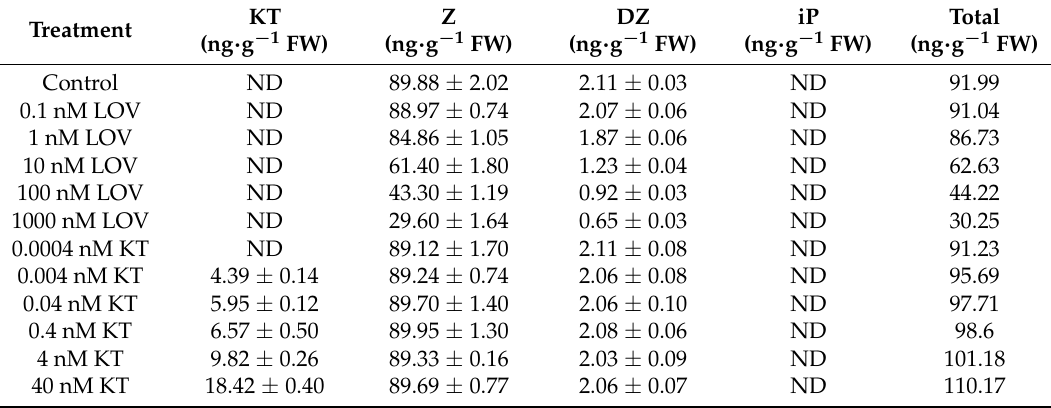
Table 1. CK content in rice seminal root under different treatments. Germinated seeds were treated with lovastatin, KT or distilled water as a control. After 4 day of treatments, CKs in rice seminal root were measured. Data are means ± standard error (SE) of three independent biological replicates. LOV, lovastatin; KT, kinetin; Z, zeatin; DZ, dihydrozeatin; iP, isopentenyladenine; ND, below detection limits; FW, fresh